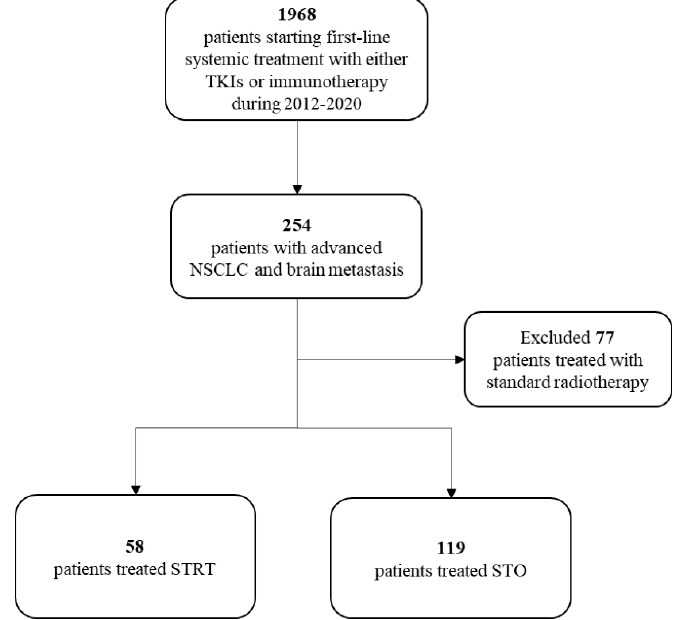
Figure 1. Flow-chart of cohort selection. List of abbreviations: NSCLC = non-small-cell lung cancer; STRT = systemic therapy and radiotherapy; STO = systemic therapy only; TKIs = tyrosine kinase inhibitor. Table 1. Baseline characteristics of 177 patients with advanced NSCLC and brain metastasis included in the study